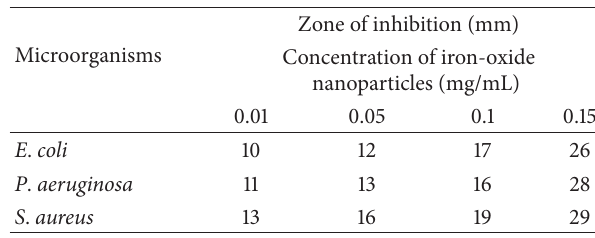
Table 1: Antibacterial activity of iron-oxide